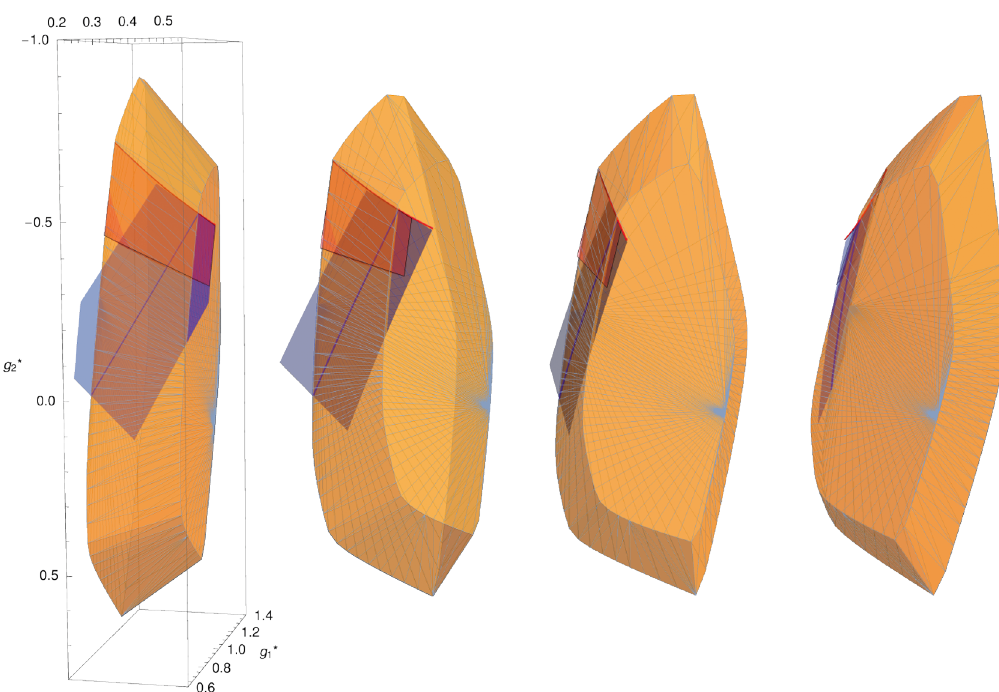
Figure 12 . Allowed region in the ( g ∗ , g ∗ ) space of O(2) symmetric correlators. The three- 1 2 dimensional shape is a tower of allowed space for external dimensions 1 / 4 ≤ ∆ v ≤ 1 / 2 . The blue line and attached surface correspond to the free vertex operator correlator and its first order correction (3.31), both of which are tangent to the bound. In red, we have the massive fermion line and the surface corresponding to the first-order Thirring perturbation (3.32). Again, these are tangent to the